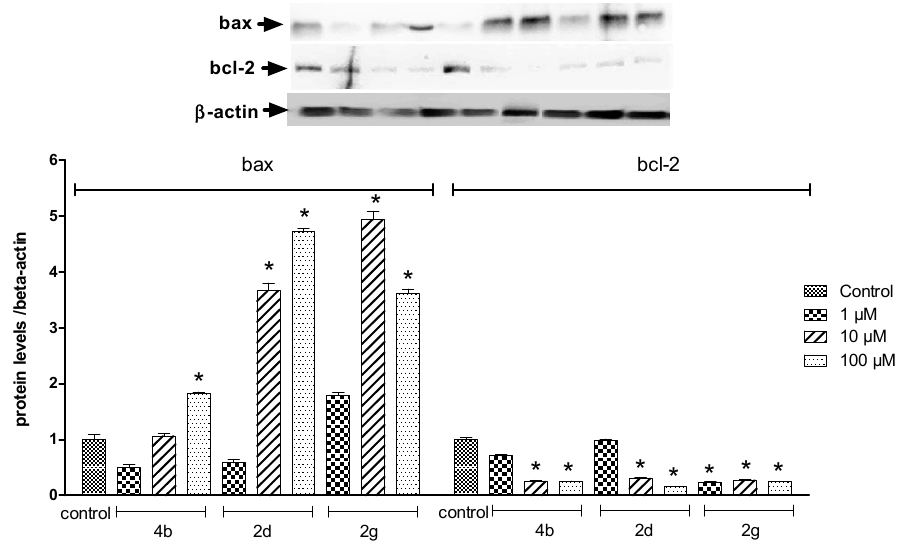
Figure 4. Changes in pro-apoptotic Bax and anti-apoptotic bcl-2 protein levels. Representative Western blots showing protein expressions of Bax and bcl-2 following the treatment of compounds 2d , 2g and 4b at three concentrations (1, 10 and 100 µ M). Graphs indicate the relative densitometric values of the proteins. Quantification of protein product was performed by densitometric scanning. Data were normalized by using the β -actin signal and are expressed as arbitrary densitometric units. Values are means SD; n = 5 in each group. * p < 0.01 significant difference from control group.